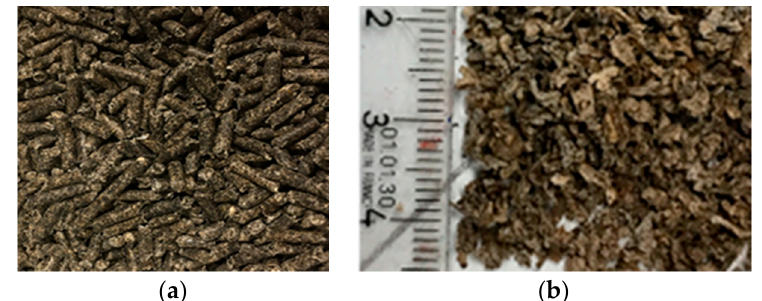
Figure 2. ( a ) Extruded beet pulp pellets; ( b ) Extruded beet pulp pellets after drying.